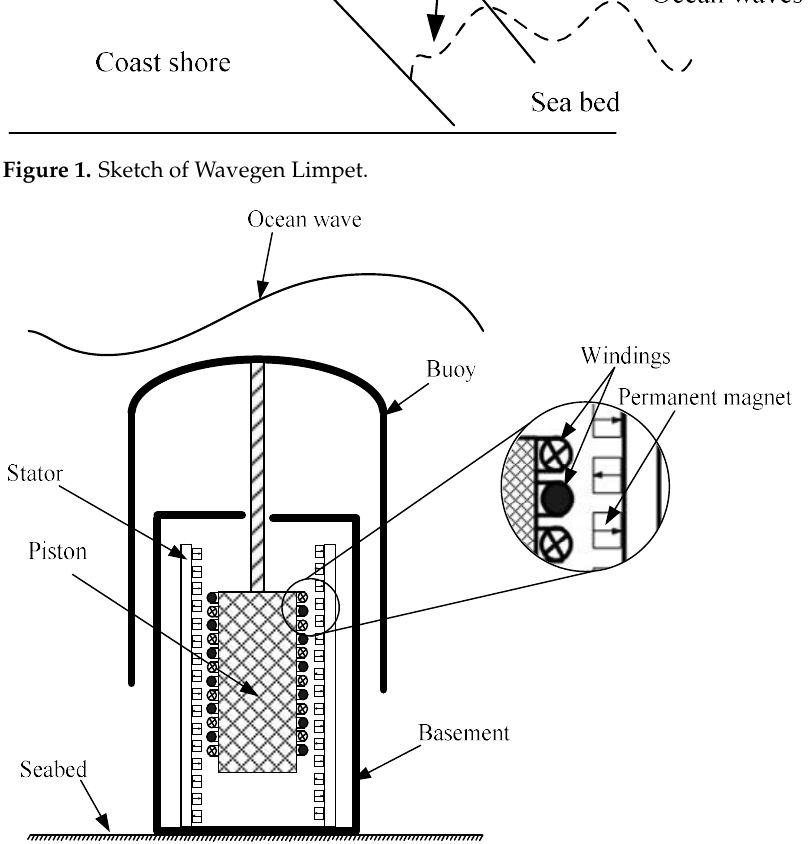
Figure 2. Sketch of AWS.